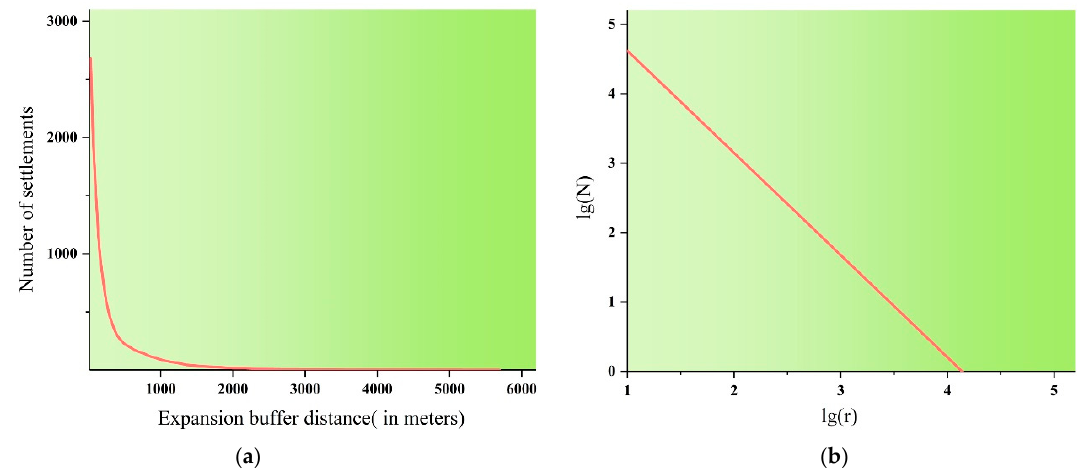
Figure 5. Urban expansion curve ( a ) and double logarithmic curve ( b